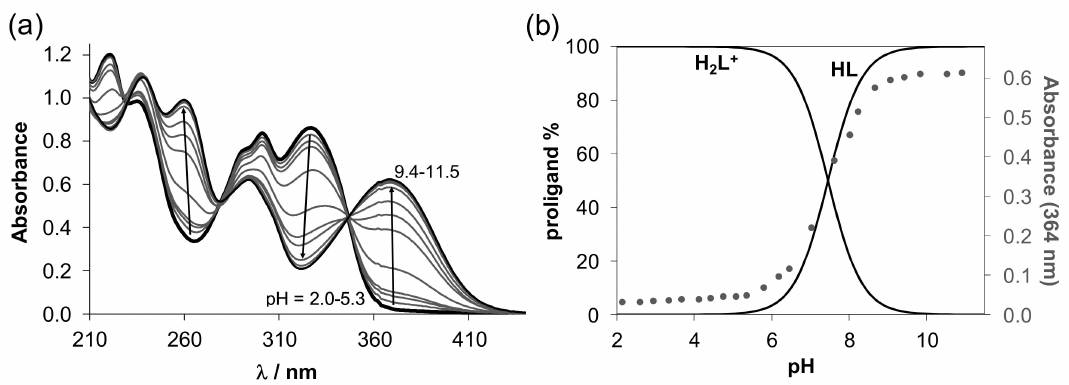
Figure 4. ( a ) UV / Vis absorption spectra of proligand [H 2 L H ]Cl at various pH values, and ( b ) its concentration distribution curves plotted together with the absorbance changes at 364 nm ( • ) ( c L = 50 µ M; I = 0.1 M (KCl); t = 25 ◦